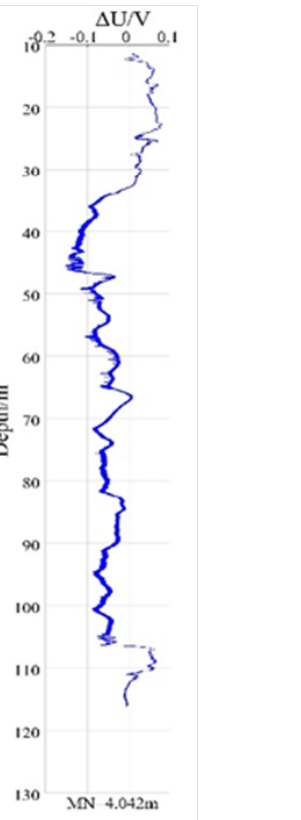
Figure 20. Electromagnetic background noise.